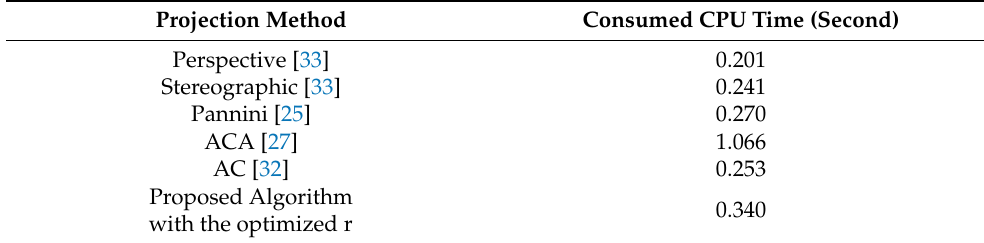
Table 3. Central processing unit (CPU) time consumed by the various algorithms.